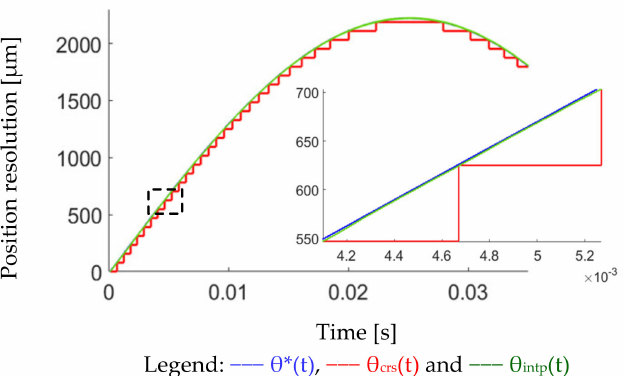
Figure 17. Comparison of different position signals under a sinusoidal position command: position command θ *, coarse position θ crs in Figure 4, and proposed interpolated position θ intp .